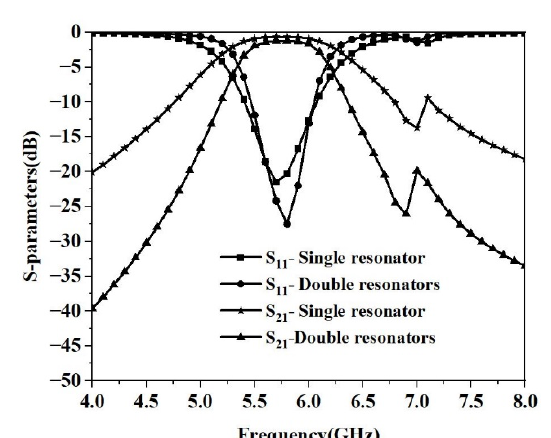
FIGURE.8. COMPARISON OF S-PARAMETERS OF BANDPASS FILTER WITHOUT FRACTAL USING SINGLE RESONATOR AND TWO RESONATORS.